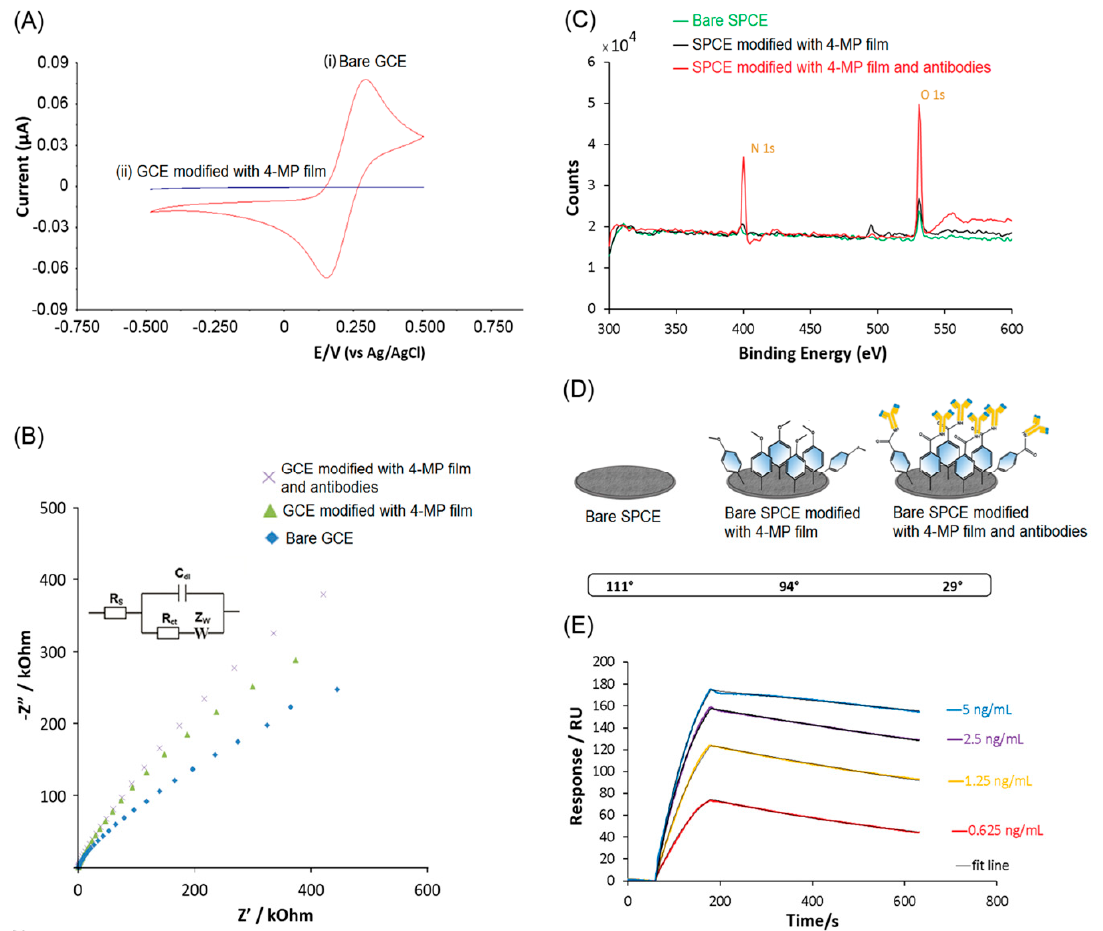
Figure 2. Surface characterization of electrode surface modifications. ( A ) Cyclic voltammogram of (i) bare glassy carbon electrode (GCE) and (ii) 4-methoxyphenyl (4-MP) film modified GCE using 10 mM [Fe(CN) 6 ] 3 − / 4 − in PBS with 100 mM KCl at 100 mV / s as described in the Materials and Methods section. ( B ) EIS measurements demonstrated with Nyquist plot ( − Z ″ vs Z ′ ) and fitted with Randles equivalent